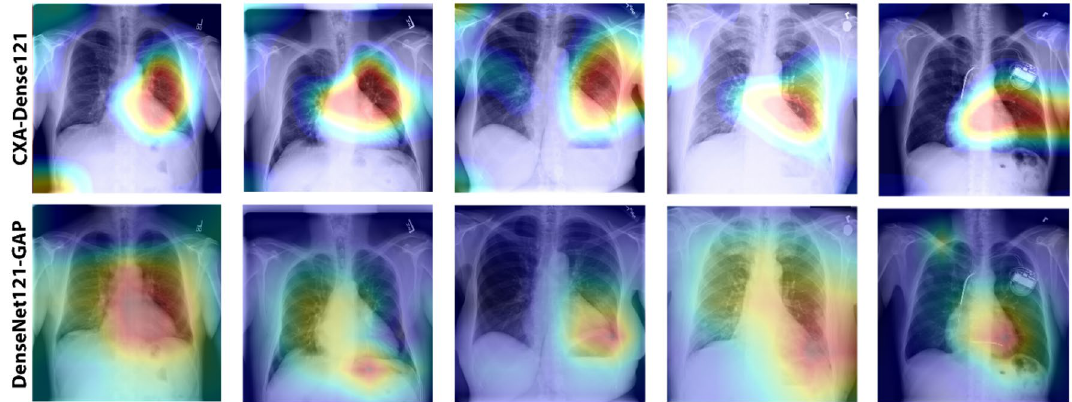
Figure 9. A visual demonstration with class-activation maps of our best model, DenseNet121 + AMM (or CXA_Dense121) and corresponding DenseNet121 + GAP model. The visual outcomes indicate that; the proposed attention mechanism method gives strong visual performance for interpreting the decision-making